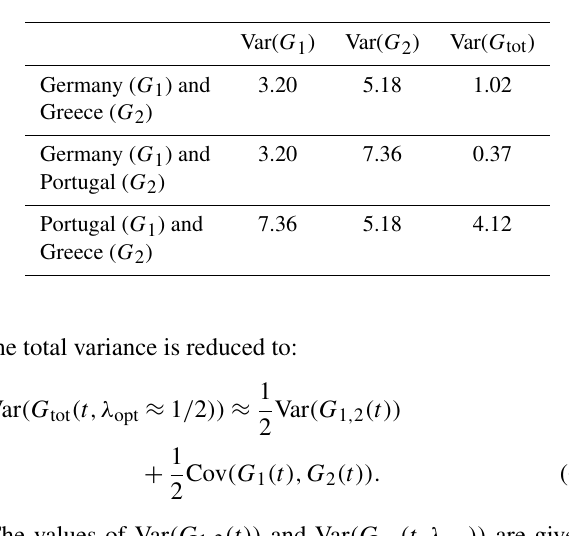
Table 1. Variances of each location (Var( G 1 , 2 )) and their combina- tions (Var( G tot )) as shown in Fig.